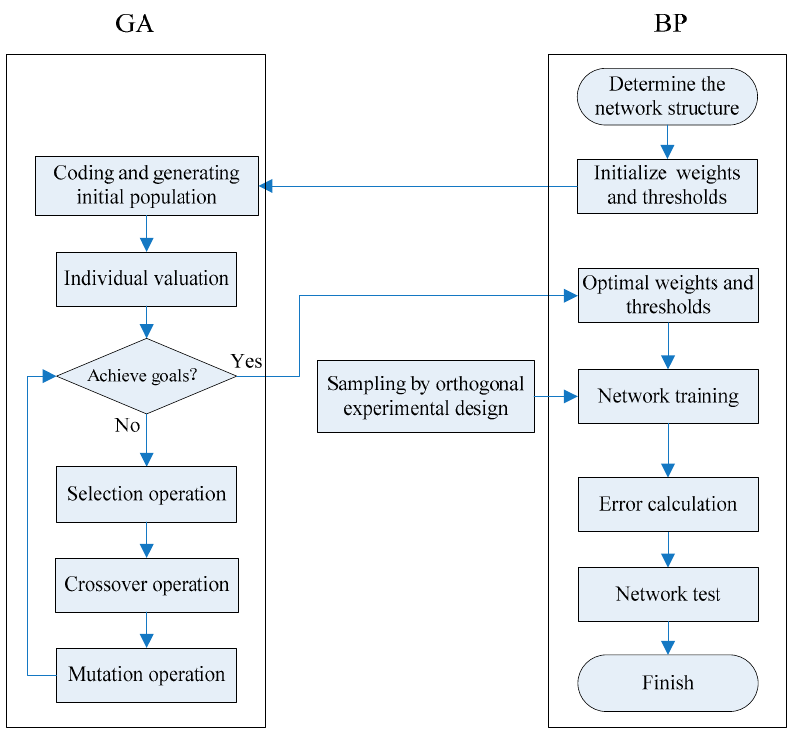
Figure 2. The flowchart of the combined method.